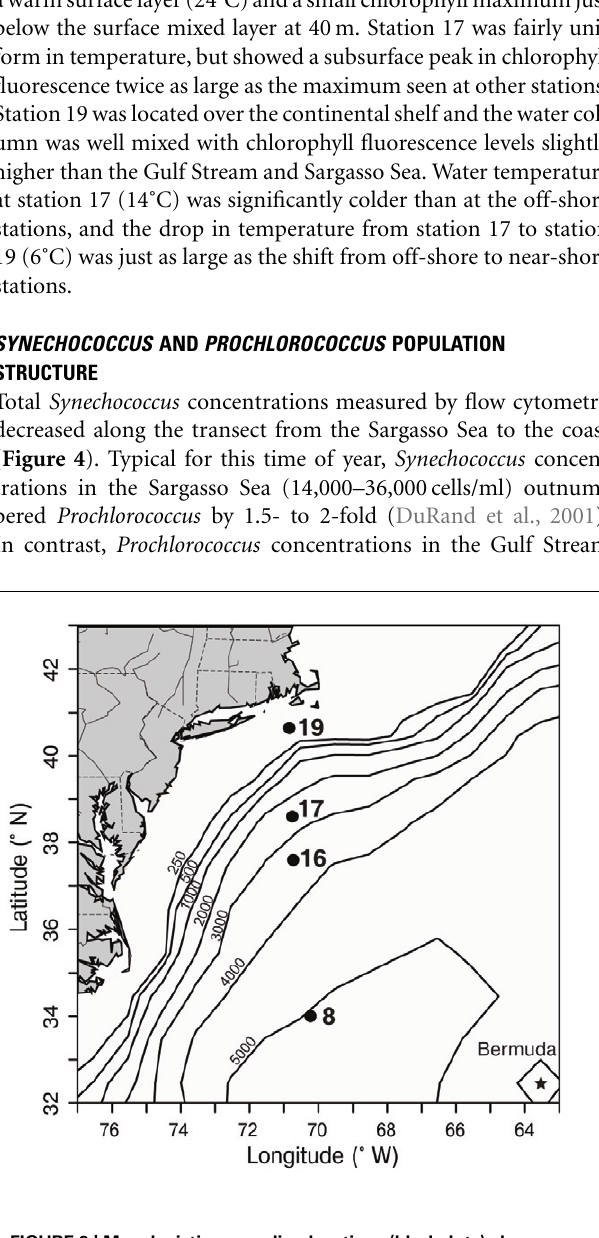
FIGURE 3 | Map depicting sampling locations (black dots) along a transect in the northwestAtlantic, south of Massachusetts in March 2002. Bathymetric contours (black lines, depth in m) are shown, and the location of Bermuda is marked with a star. Station 8 was located in the Sargasso Sea and station 16 was located in the Gulf Stream (based on satellite sea surface temperature, data not shown). Stations 17 and 19 represent coastal